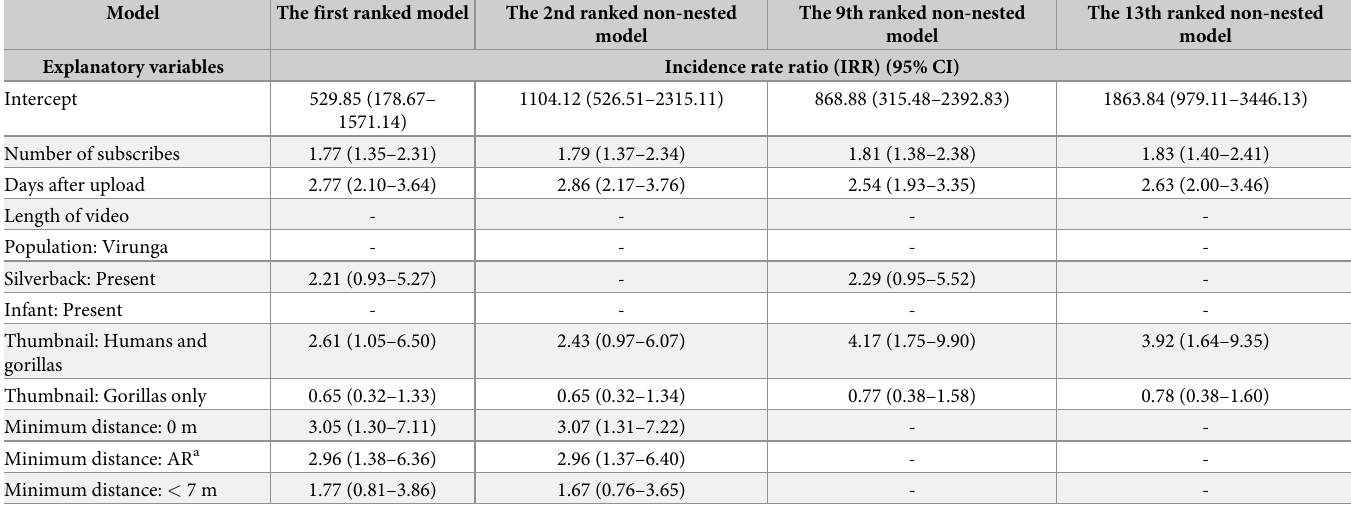
Table 2. Summary of the models exploring the factors that affect the number of views and likes of YouTube videos related to mountain gorilla tourism (N = 206). The incidence rate ratio (IRR) and 95% confidence interval (CI) of each explanatory variable in the first ranked model and non-nested models are shown.